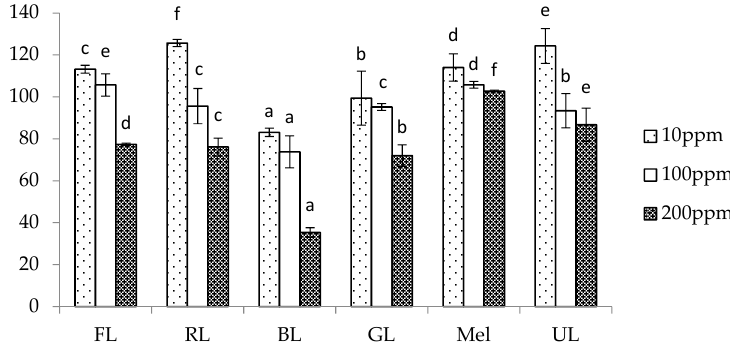
Figure 6. The effect of the peanut sprout concentration on the viability of RAW 264.7 cells. FL: fluorescence light, RL: red LED, BL: blue LED, GL: green LED, MEL: micro-electrodeless light, and UL: ultrasound+ FL. Mean values within a column with the same lowercase letters were not significantly different ( p < 0.05), according to Duncan’s multiple comparison test. 3.6. Antimicrobial Activity of Peanut Sprouts Measured Using the Zone of Inhibition Assay The antimicrobial activity of peanut extracts exposed to LED light was tested against Table 2. Antimicrobial activity of the peanut sprout extracts based on the zone of inhibition against the selected pathogens. various Gram-positive and Gram-negative bacteria (Table 2). As depicted in Figure 7, the zone of inhibition varied in the different tested samples. The results showed that the an- Microbial Strains timicrobial activity of peanut sprouts grown under blue LED was effective against E. coli